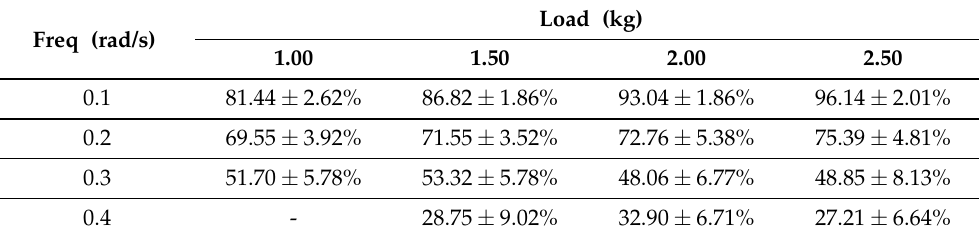
Table 2. Percentage of the initial wire length recovered.